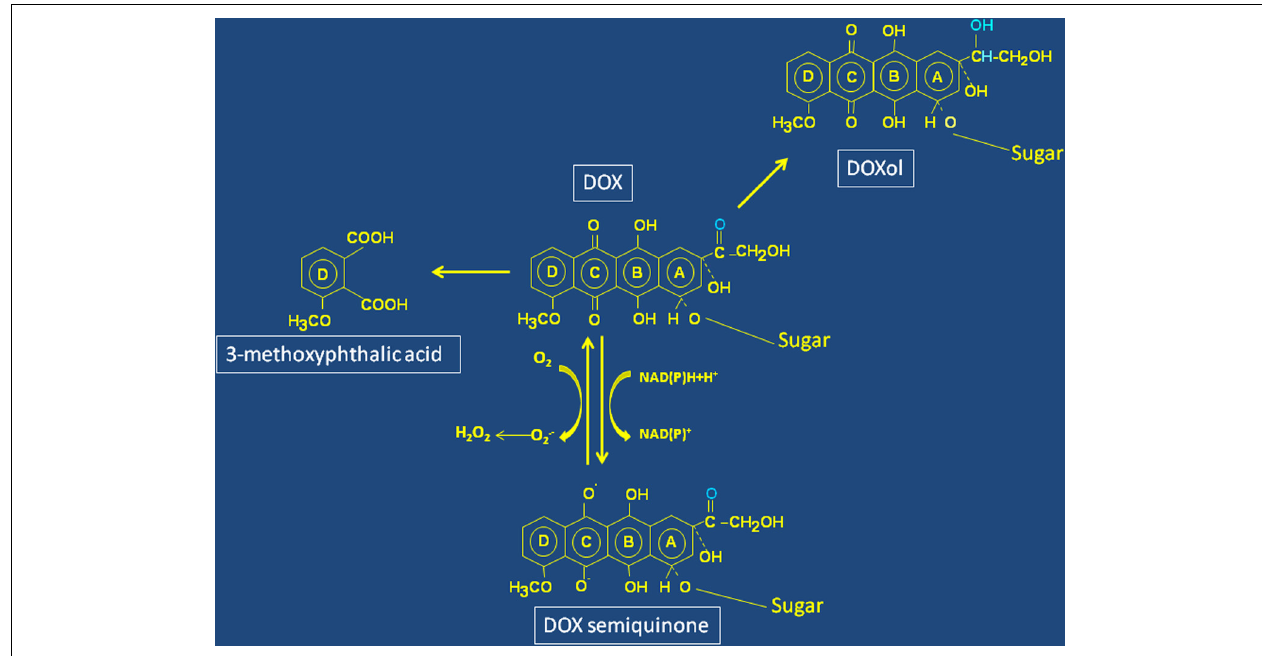
FIGURE 1 | Structure and simplified scheme of molecular transformations of Doxorubicin. Redox cycling between the quinone and semiquinone forms (ring C) of Doxorubicin (DOX) leads to oxygen radicals formation.The residue involved in DOXol formation following two-electron